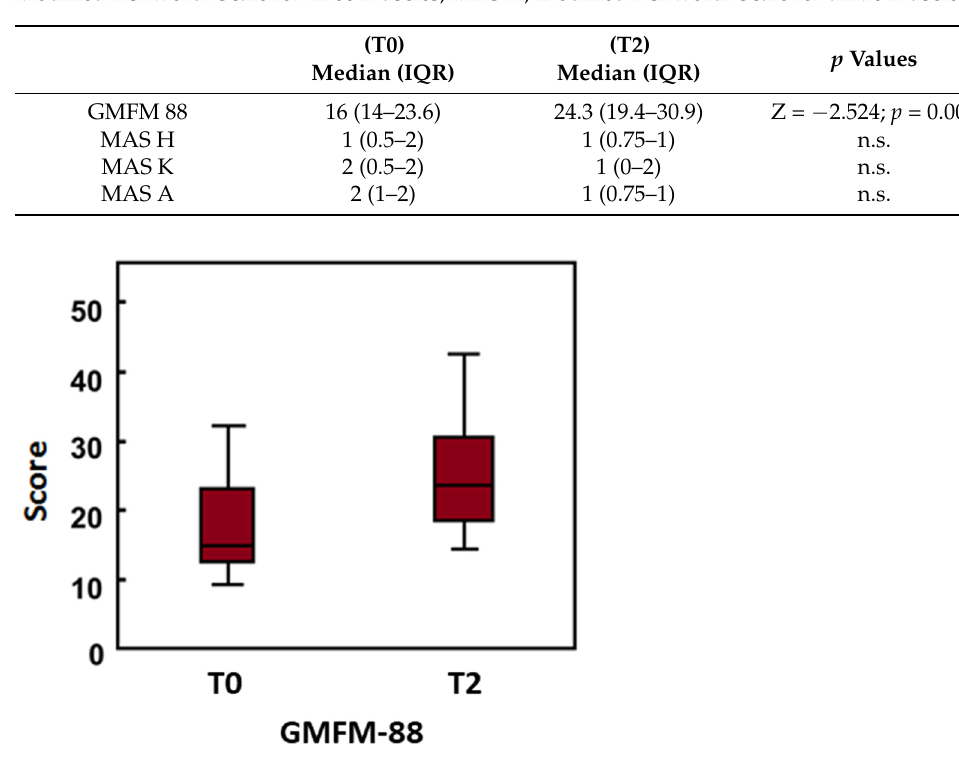
Figure 3. Boxplot associated to the Gross Motor Function Measure (GMFM-88) evaluated at T0 and T2.